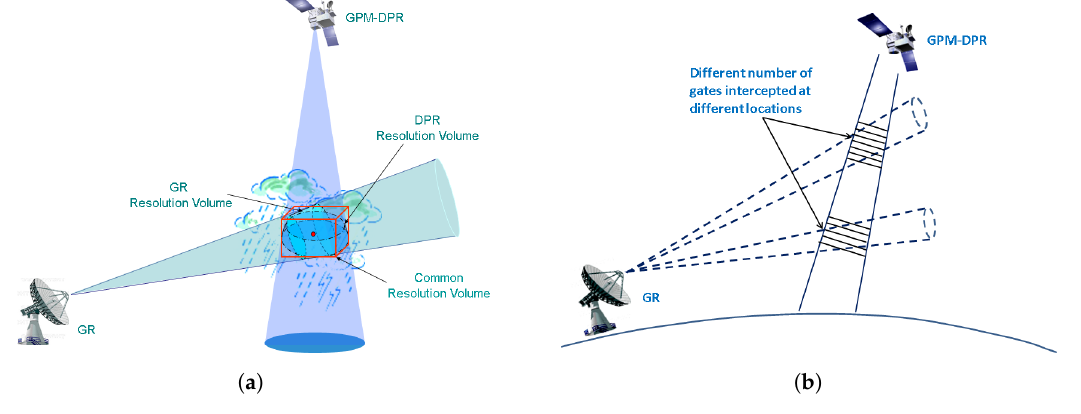
Figure 3. Diagram illustrating viewing geometry of DPR and GR. ( a ) Intersection of DPR and GR common volumes. ( b ) Cartoon showing different number of DPR gates at common intersection locations for different GR sweeps. Image adapted from